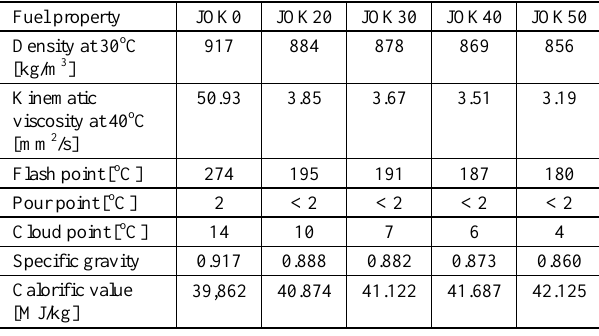
Table 4: Summary of the properties of jatropha oil with kerosene and diesel